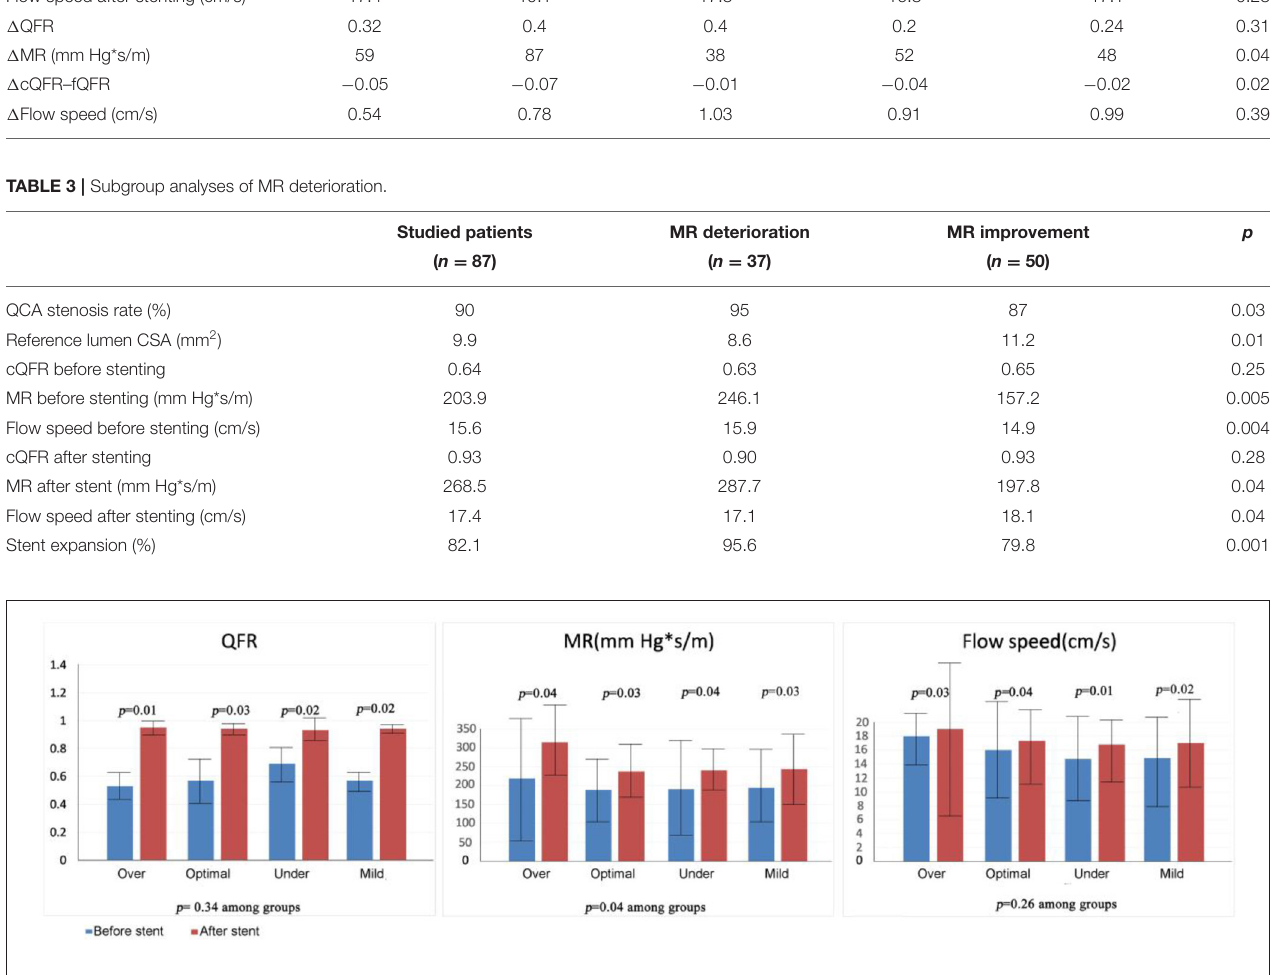
FIGURE 5 | Data of QFR